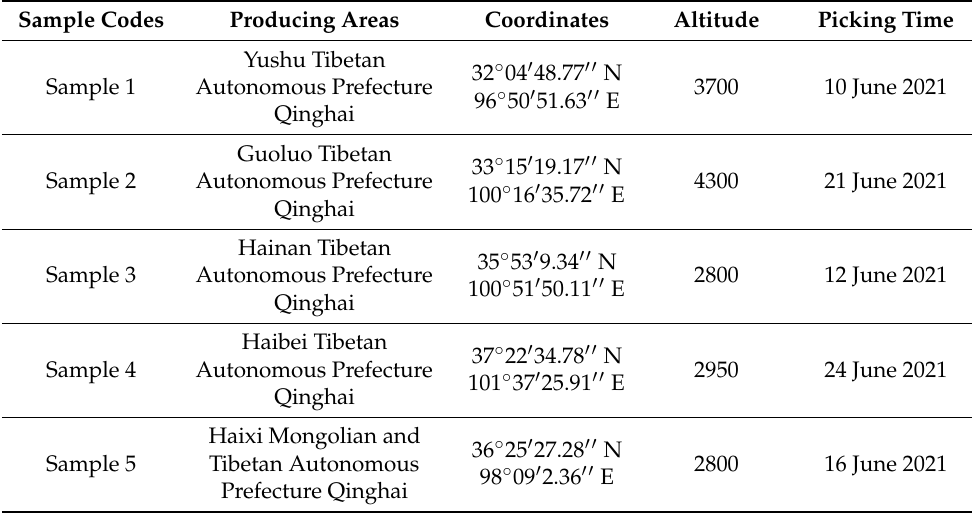
Table 1. Information about the Potentilla anserina L. samples used in this study. Sample